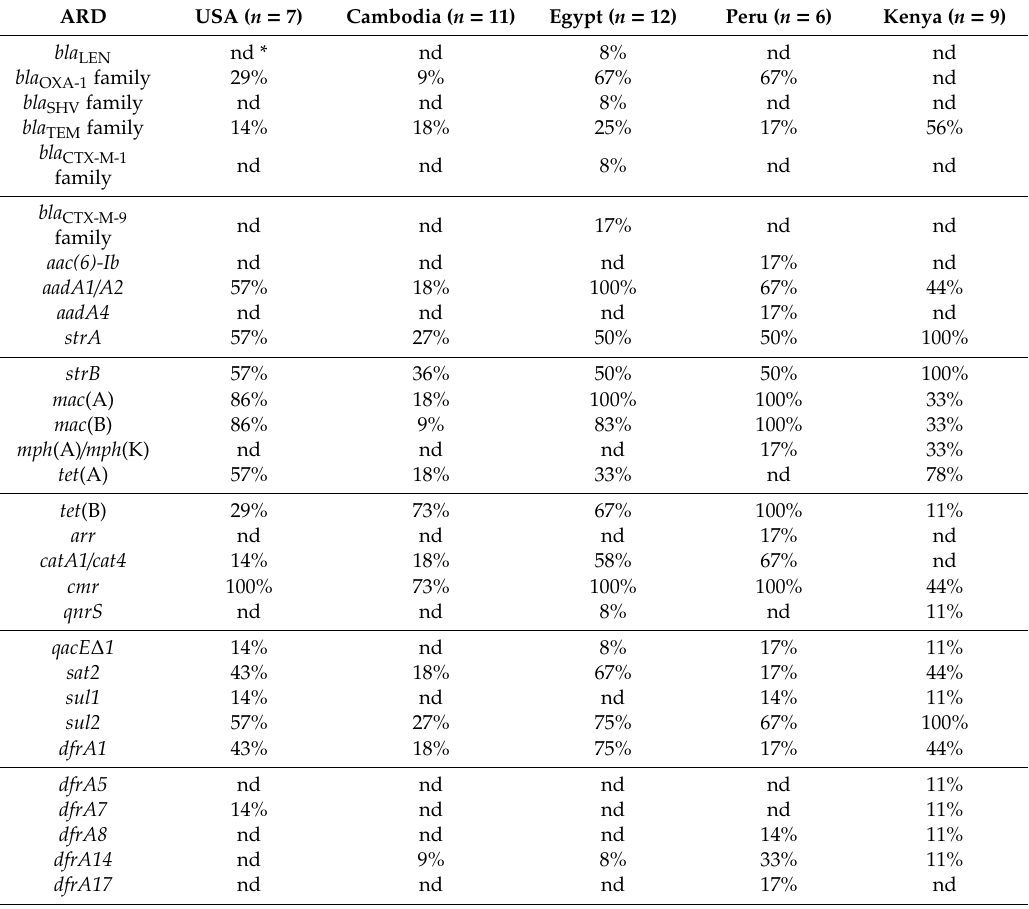
Table 4. ARDs detected in Shigella spp., by geographic location (percent of isolates